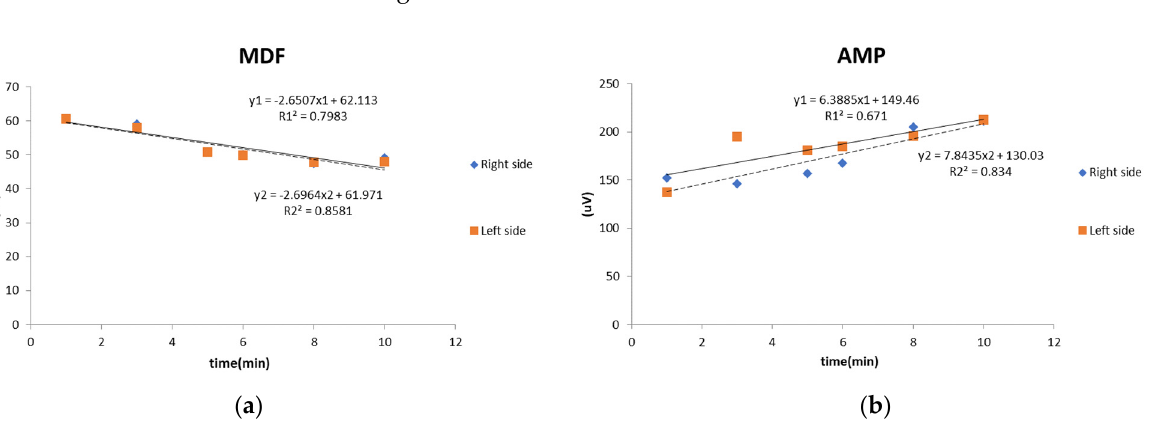
Figure 2. EMG parameters of rectus abdominis muscle during rectus abdominis muscle fatigue involvement: ( a ) MDF (median frequency); ( b ) AMP (mean amplitude).